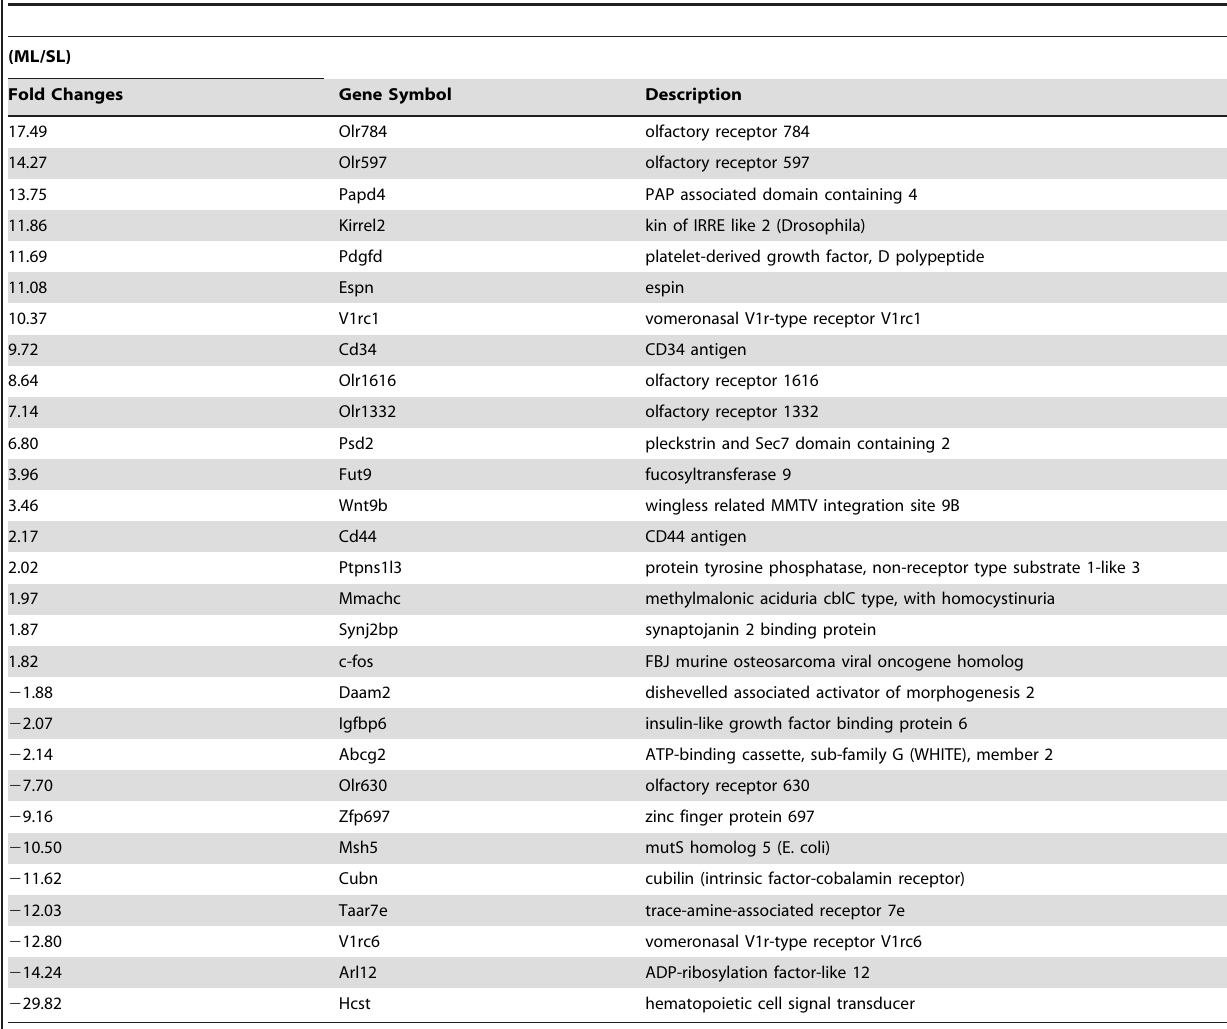
Table 5. METH-induced changes in levels of gene transcripts on the lesioned side of hemiparkinsonian rats.